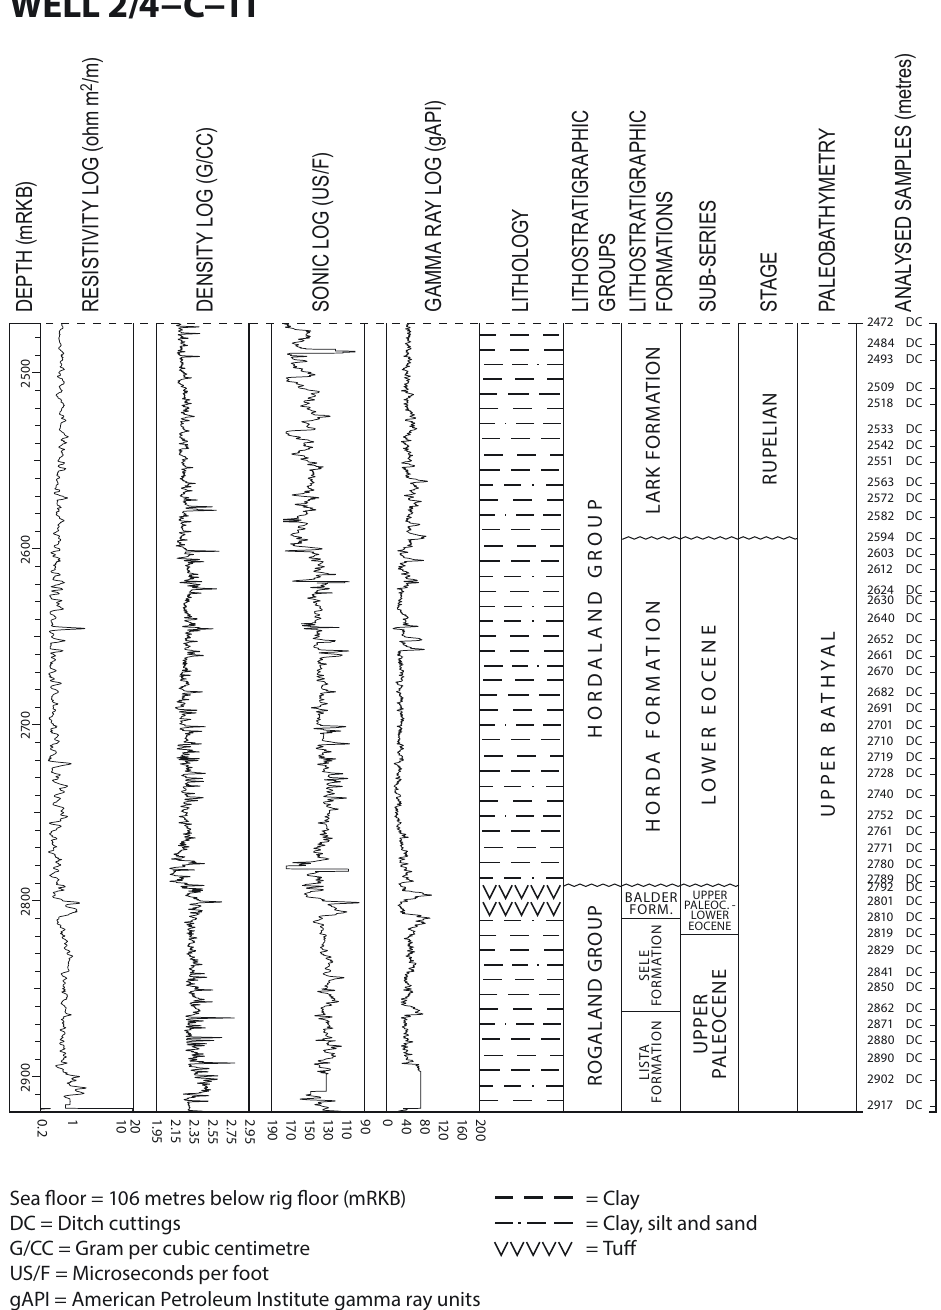
Figure 24. Well summary figure including resistivity log, density log, sonic log, gamma-ray log, lithology, litho- stratigraphic units, sub-series, stage, paleobathymetry and analysed samples for the lowest part of the investigated sequence in well 2/4–C–11 (upper Paleocene to Rupelian (lower part)) including the supplementary well reference sections for the Lark Formation (lower part) and the Horda Formation (modified after Eidvin et al.,